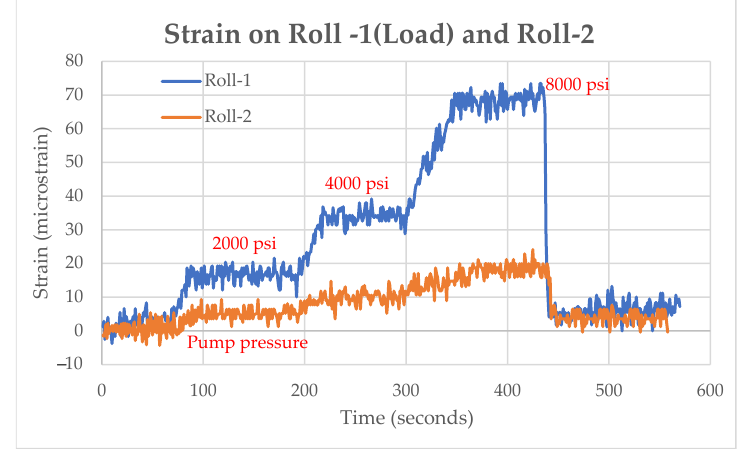
Figure 13. Strain crosstalk observed on Roll-2 when load is applied to Roll-1 . The position of hydraulic jacks was also changed to the center of rolls between the bearings from positions adjacent to the bearing. The strain measured with varying loads was observed for this loading configuration in Figure 14. The results suggested that the sensors should also be sensitive to changes in slab width, enabling the sensors to be used across varying steelmaking practices and product widths.